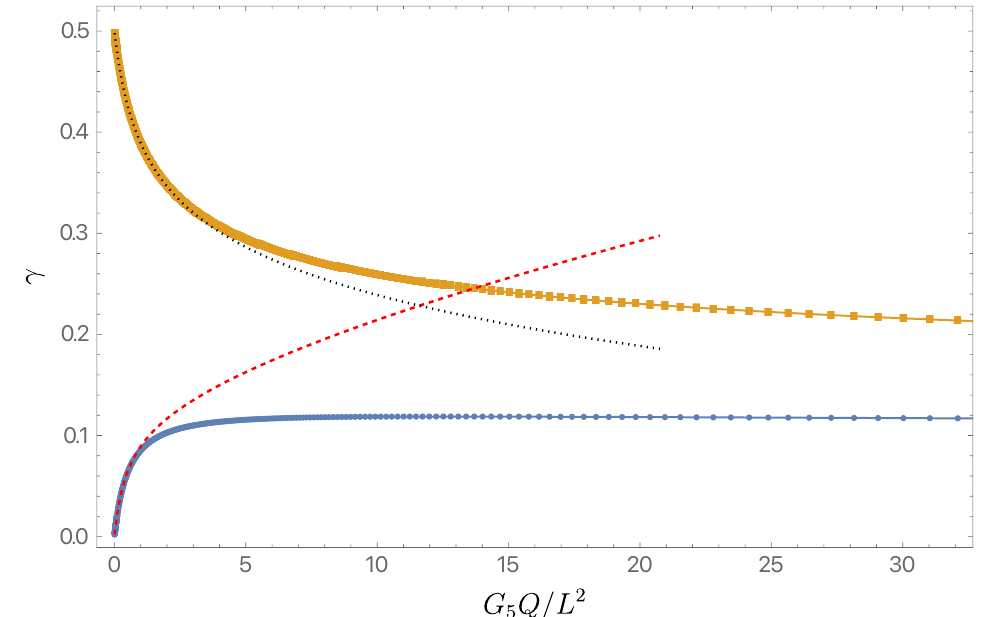
Figure 8 . The two lowest lying modes of the quadratic Stürm-Liouville equations eq. (3.26c) and eq. (3.26d) governing perturbations of the new near horizon geometries. The red dashed line shows the perturbative result displayed in eq. (3.30), whereas the black dotted line shows γ given in eq. (3.31). The blue disks have ‘ = 2 and the orange squares have ‘ = 3 . In the language used in section 2, the modes shown both connect to γ − ( ‘, 0)